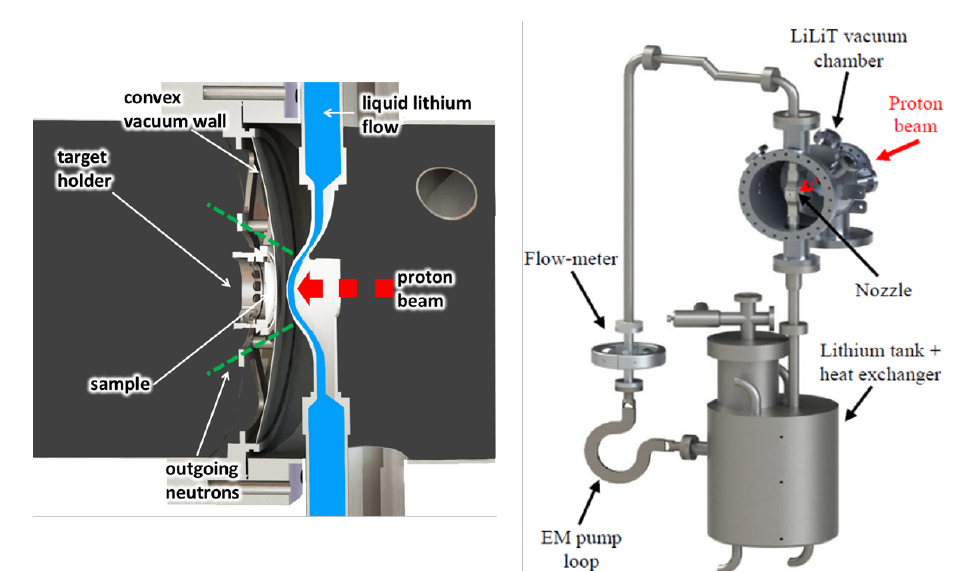
Figure 2: (right) Schematic drawing of the Liquid-Lithium Target (LiLiT). (left) Diagram of the Liquid-Lithium Target (LiLiT) and activation target assembly. The (1-2 mA, ≈ 9 mm full width) proton beam (dashed red arrow) impinges directly on the windowless liquid-lithium film. The light blue shows the liquid-lithium circulating flow (see [7] for details). The activa- tion samples are mounted at the center of a ring target holder made of Al and positioned in the outgoing neutron cone (green dashed lines) at a distance of ≈ 6 mm from the liquid-lithium film surface. The targets are in a vacuum chamber separated from the LiLiT chamber by a 0.5 mm stainless steel concave vacuum